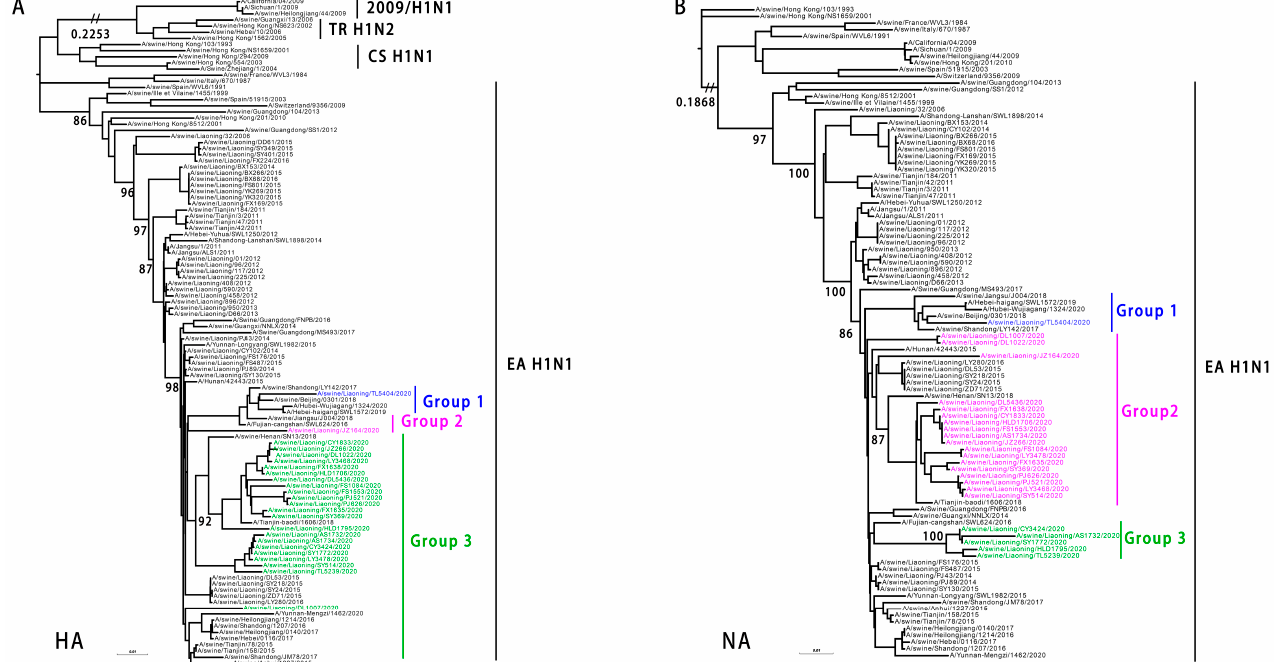
Figure 3. Genetic relationships among the HA and NA genes of EA H1N1 SIVs. ( A ). Phylogenetic tree of HA. The unrooted tree was based on nucleotides 33–1733. Sequences of viruses with names in black were downloaded from available databases; viruses with names in colors were sequenced in this study. ( B ) Phylogenetic tree of NA. The unrooted tree was based on nucleotides 21 to 1430. Scale bar indicates the number of nucleotide substitutions per site. 2009/H1N1, 2009 pandemic H1N1; EA H1N1, Eurasian avian-like H1N1; CS H1N1, classical swine H1N1; TR H1N2, triple reassortant